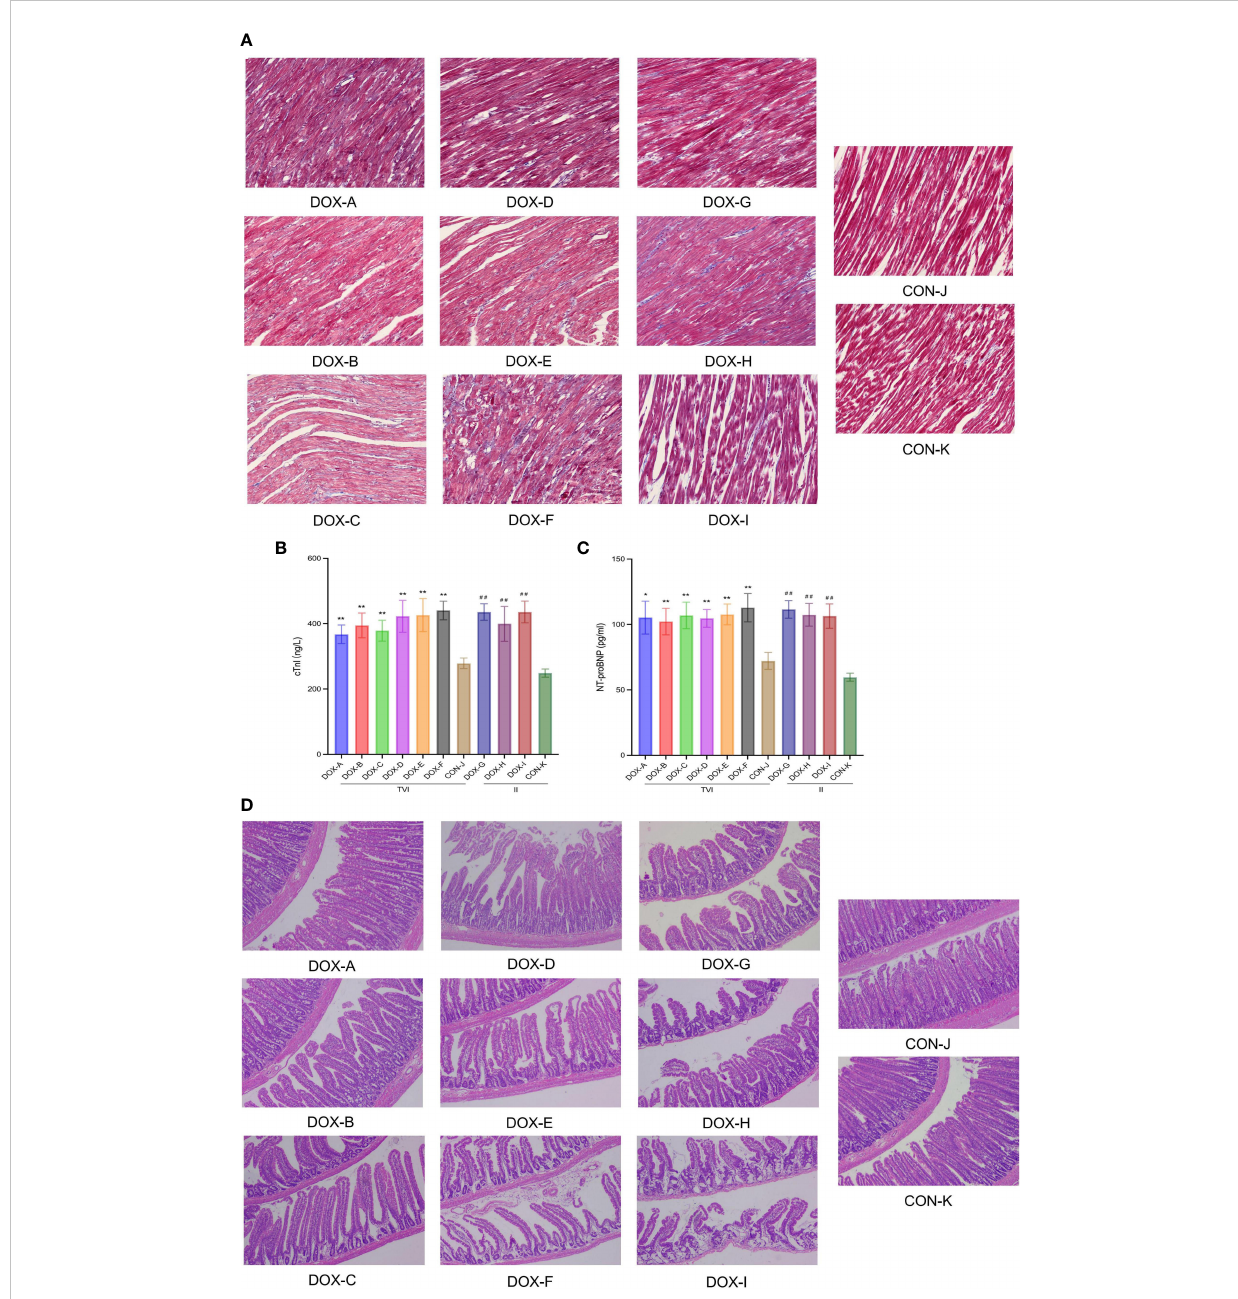
FIGURE 4 (A) Myocardial fifi brosis observed under a light microscope with Masson staining (Magni fi cation ×200, Scale bar = 100 µm). (B, C) The levels of cTnI and NT-proBNP in the serum.CON, control; DOX, doxorubicin; TVI,tail vein injection; II,intraperitoneal injection. Data are presented as means ± SD (n = 5). (D) Pathological changes observed under a light microscope with H&E staining (Magni fi cation ×200, Scale bar = 100 µm). CON, control; DOX, doxorubicin.* P < 0.05, ** P < 0.01 vs. CON-J; ## P < 0.01 vs.